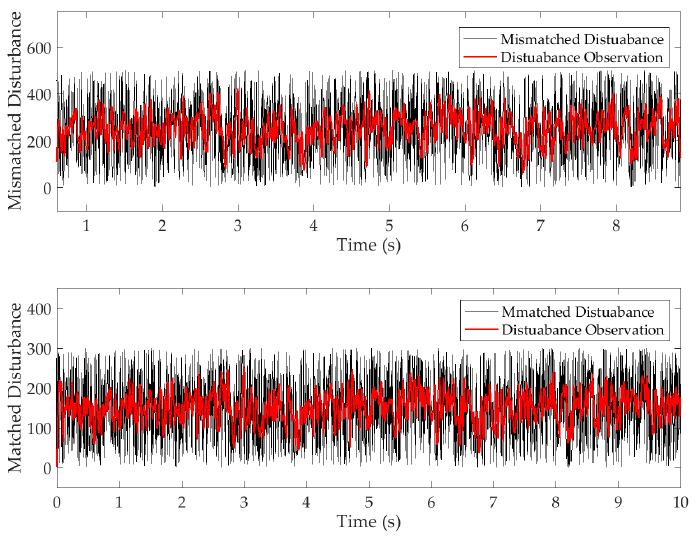
Figure 15. Time response of the